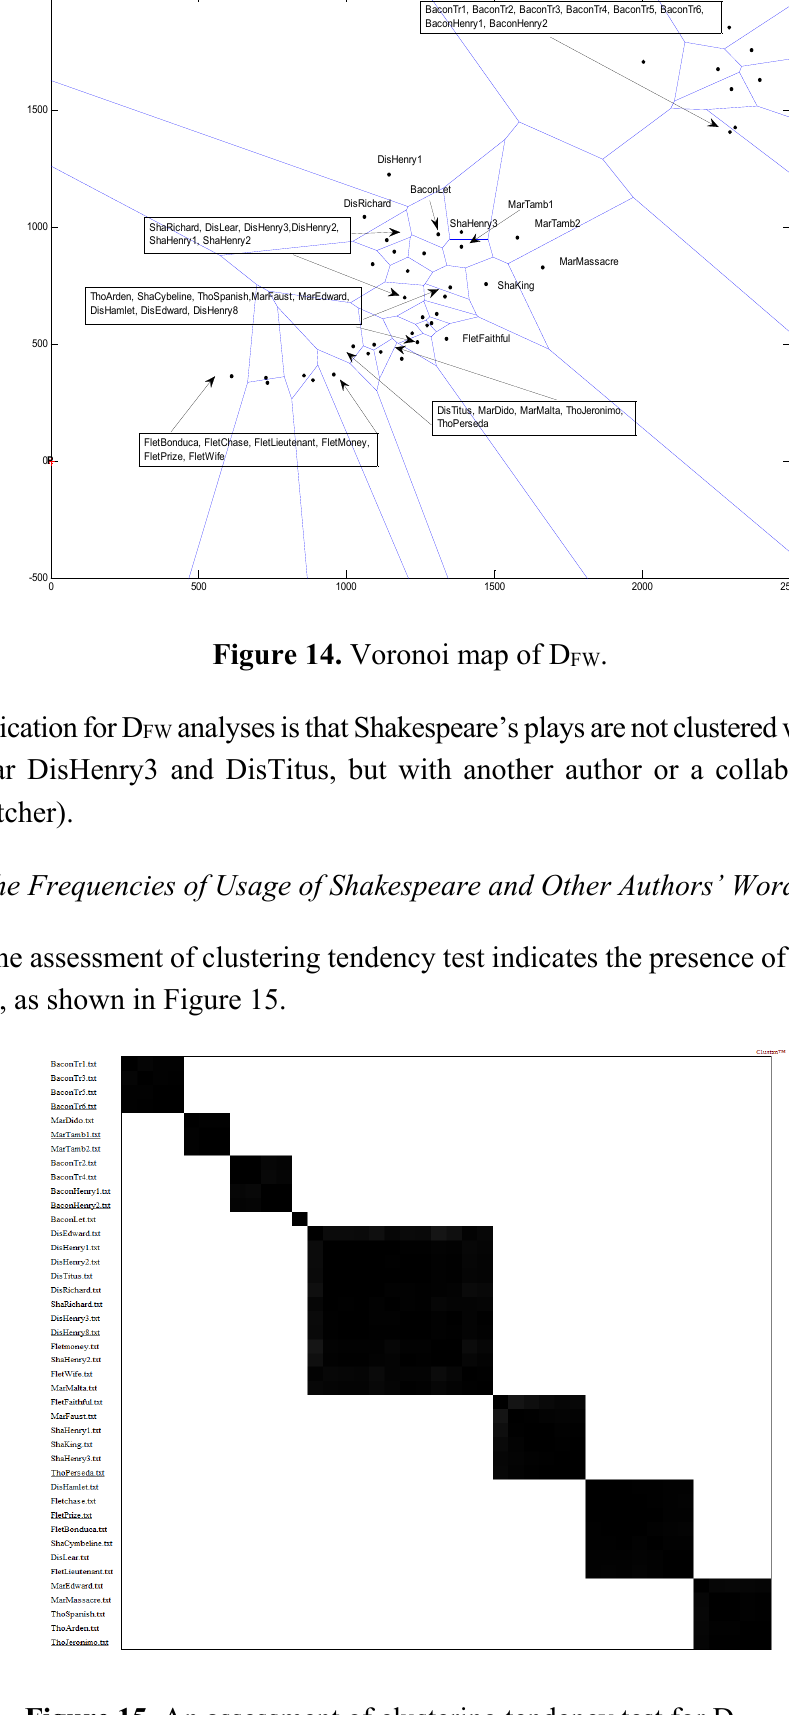
Figure 15. An assessment of clustering tendency test for D bigram